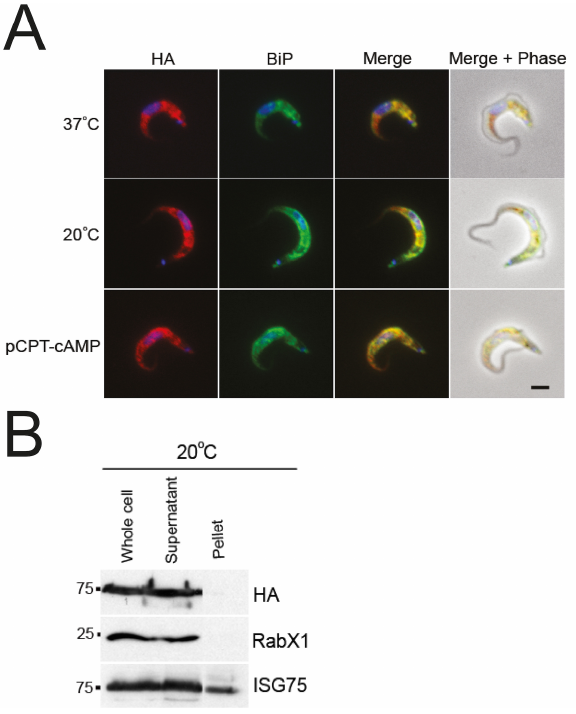
FIGURE 8: IGP48 is retained in the ER in short stumpy-like cells. (A) BSF cells expressing IGP48-HA were incubated at 37°C, 20°C (cold-shock) or with pCPT-cAMP for 12 hours. IGP48-HA was visualised with anti-HA antibody and co-stained with anti-BiP antibody. IGP48-HA remains in the ER in short stumpy-induced cells. DNA was visualised using DAPI. All images are captured at the same magnification, scale bar 2 μm. (B) Surface biotinylation was performed to determine if IGP48-HA reaches the cell surface in short stumpy-like cells. Cells were cultured in vitro at 37°C or 20°C for 12 hours and the biotinylation assay was carried out as described previously. IGP48-HA was detected by Western blot with anti-HA antibody. Blots were stripped and re-probed for an intracellular marker, RabX1 (localises to the ER) and a surface marker, ISG75, which localises to both the surface and endoso- mal